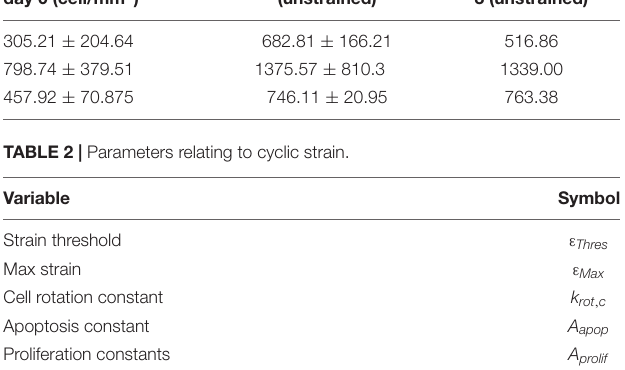
TABLE 1 | Change in cell density at day 3 (unstrained) (Mathieu, 2020; Mathieu et al., 2020). Experimental cell density day 0 (cell/mm 2 )